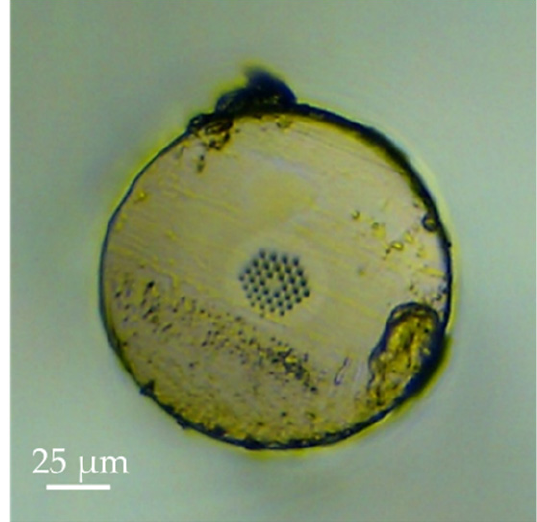
Figure 2. Cross-section of the 3-ring PMMA